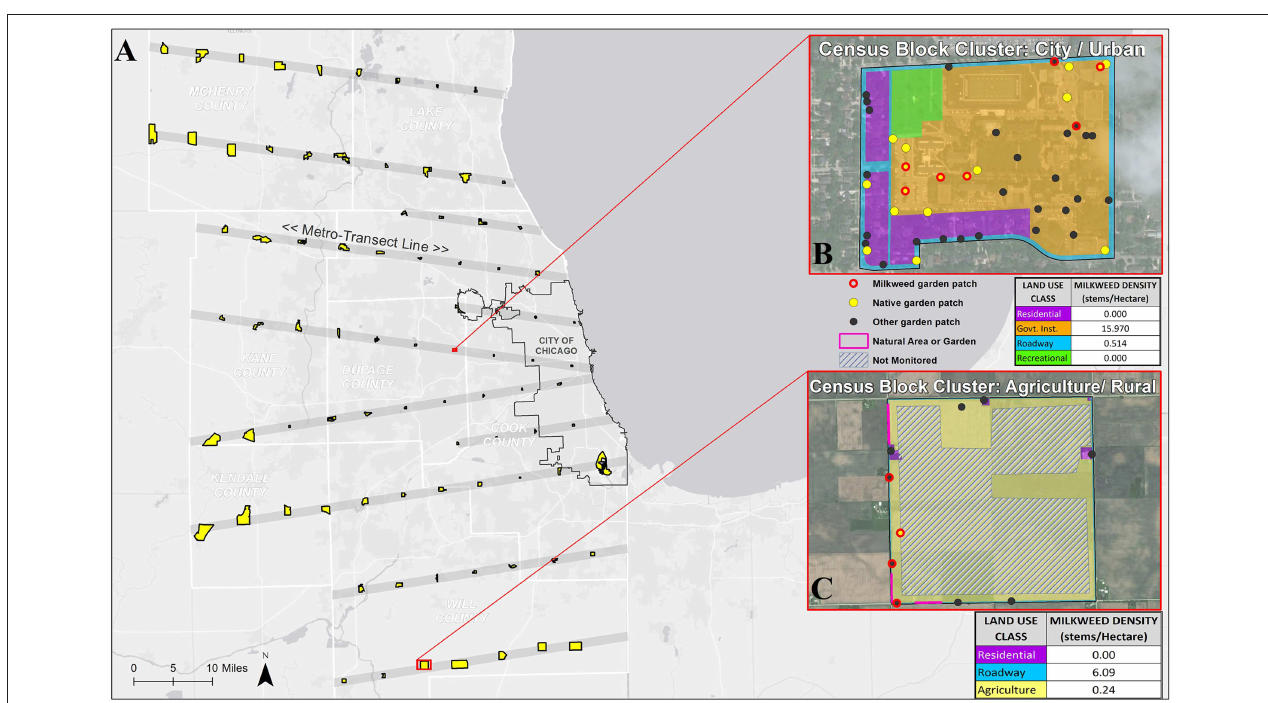
FIGURE 5 | Example of metro-transect lines and sampling locations in Chicago. Milkweed and habitat data was collected along “metro-transects” which run from high to low human population density zones. Sampling areas in yellow on the main map (A) are clusters of US census blocks that intersect with the sampling points every five miles. In this example from the Chicago metropolitan area, we show the comparison between an urban census cluster (B) vs. a rural census cluster (C) . Shading color indicates the land use, points are where habitat was encountered (red point contain milkweed), and hatching indicates areas that could not be